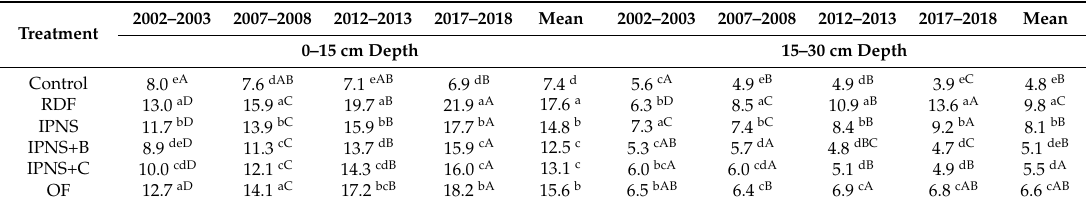
Table 6. Effects of different nutrient management options on soil Olsen-P (mg kg − 1 ) at soil depths of 0–15 and 15–30 cm after 5 RWS cycle intervals.